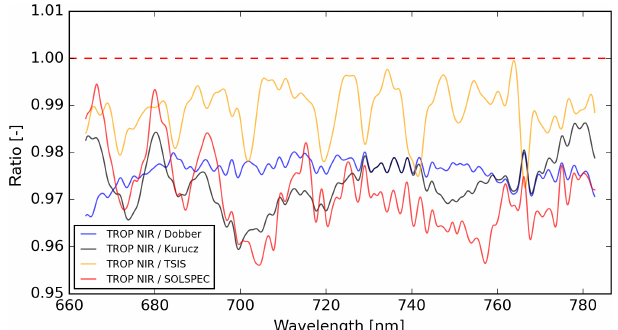
Figure 22. The ratio of the NIR spectrum via QVD1 in orbit 2818 with respect to the Dobber (blue), Kurucz (green), TSIS (orange) and SOLSPEC (red) spectra. All NIR spectra are convolved with a σ = 1 . 0nm Gaussian kernel.